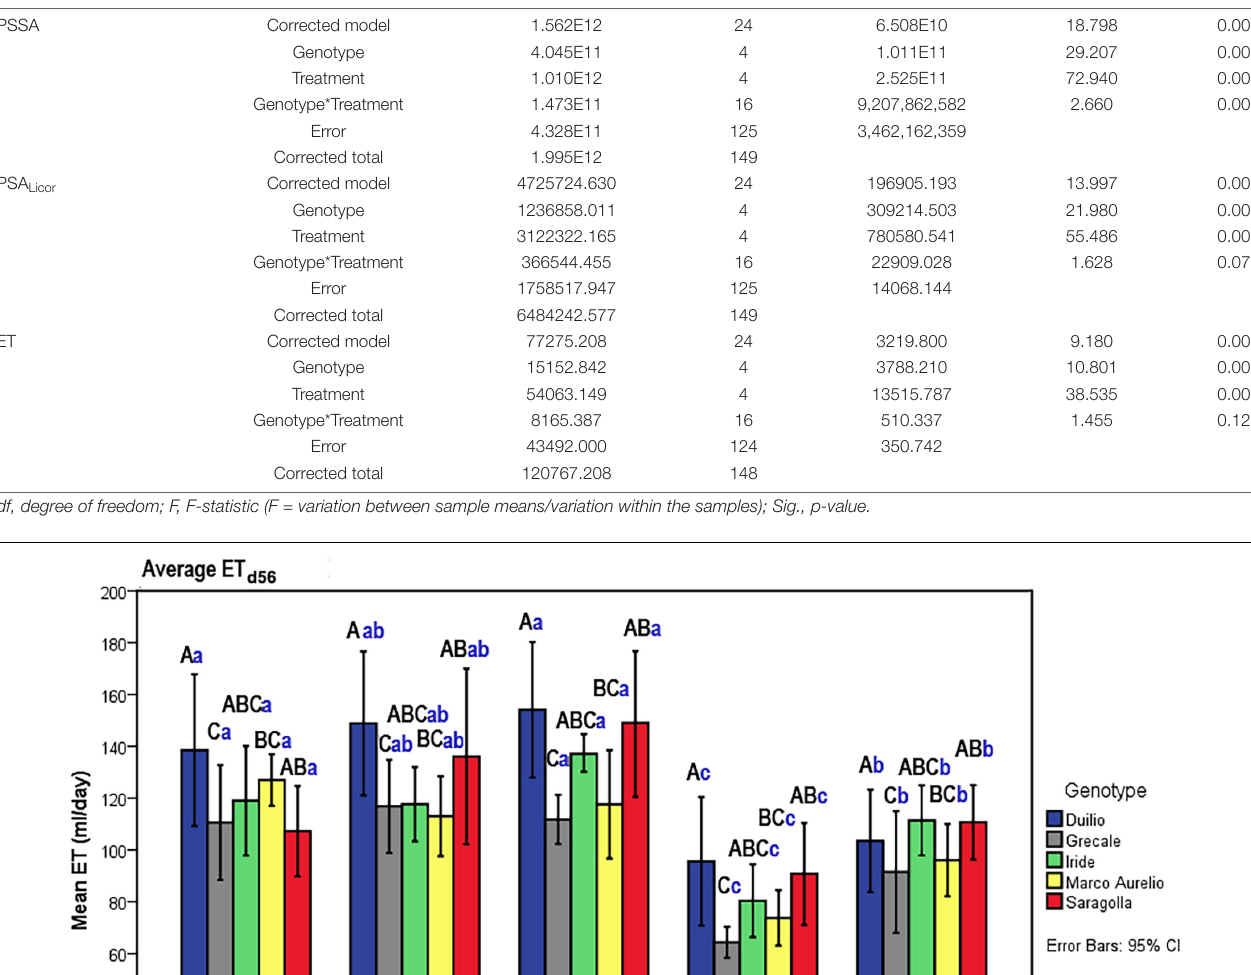
TABLE 5 | Results of the two-way analysis of variance (ANOVA) (tests of between-subjects effects) on PSSA, PSA Licor , and ET data at the end of T f , with “genotype” and “treatment” as fixed factors. Dependent variable Source Sum of squares df Mean square F Sig.